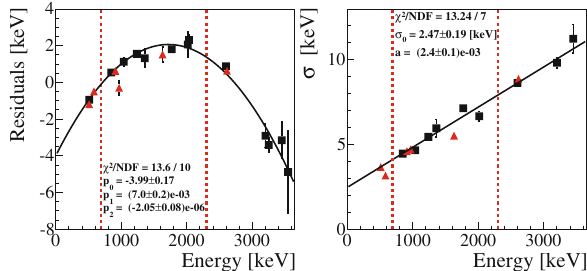
Fig. 2 Validation of the 232 Th calibration (red triangles) with a 56 Co source (black squares). All the energy spectra of the ZnSe crystals were calibrated using the coefficients derived from the fit of the most promi- nent 232 Th peaks. Left: residuals of the calibration, defined as (nominal energy - μ ), as a function of the energy; the data obtained with 56 Co are modelled with a parabolic function (black line). Right: the energy resolution measured for different lines is shown as a function of the energy. Data reported in this plot are modeled with a linear function (see text). The vertical dashed lines indicate the region of interest